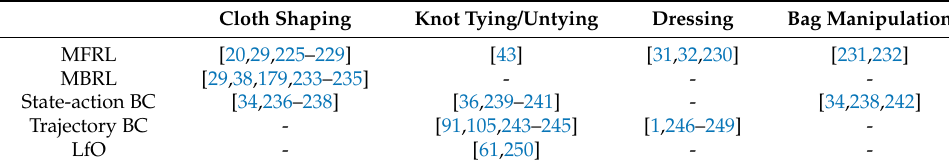
Table 1. Overview of data-driven CDO literature Cloth Shaping Knot Tying/Untying